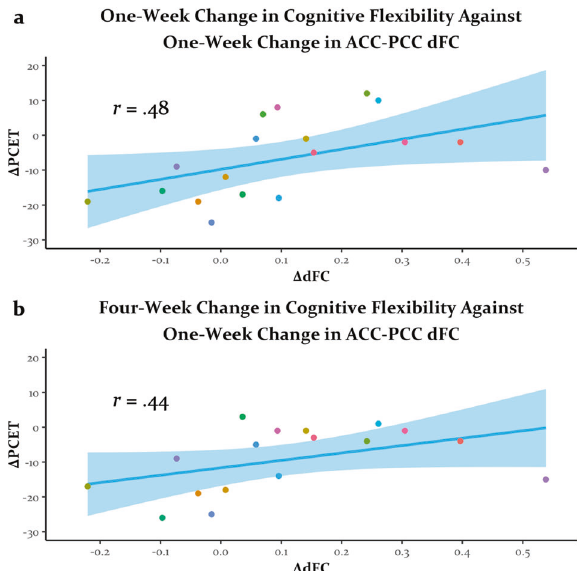
Fig. 3 Greater pre- to post-psilocybin therapy increases in neural fl exibility were associated with less improvements in cognitive fl exibility. Relationship between changes in anterior to posterior cingulate cortex (ACC and PCC, respectively) dynamics of functional connectivity (dFC) 1 week post-psilocybin therapy and changes in perseverative errors on the Penn Conditional Exclusion Test (PCET) at ( a ) 1 week and ( b ) 4 weeks post-psilocybin